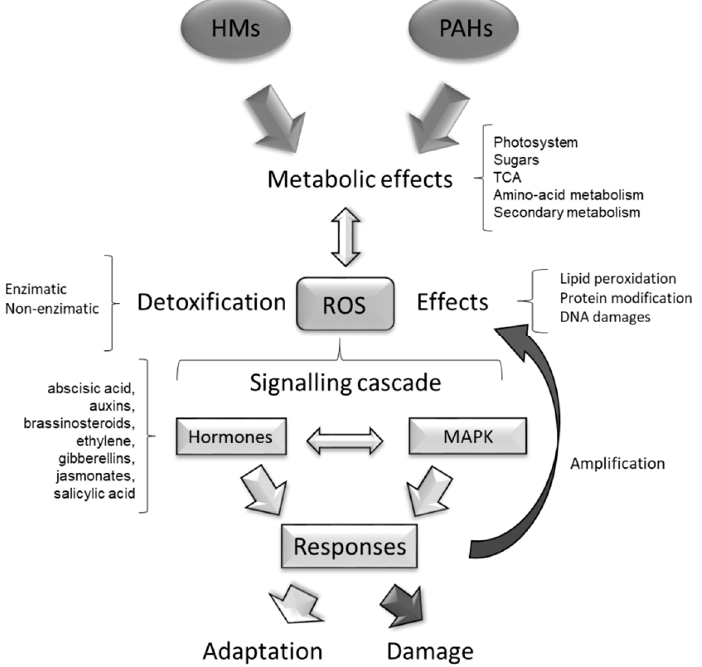
Figure 6. Schematic representation of the cascade of responses triggered by HMs and PAHs in plants. Depending on the intensity of the process, adaptation to stress or cellular damage and cell death is the final outcome of the process.